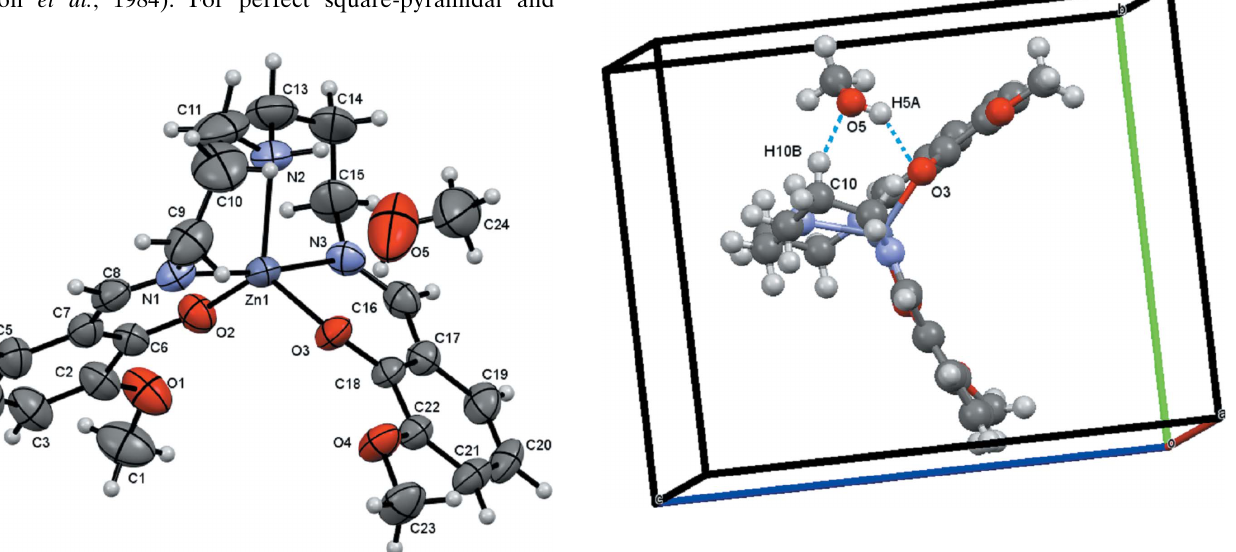
Figure 1 The molecular structure of the title compound, showing the atom- labelling scheme.